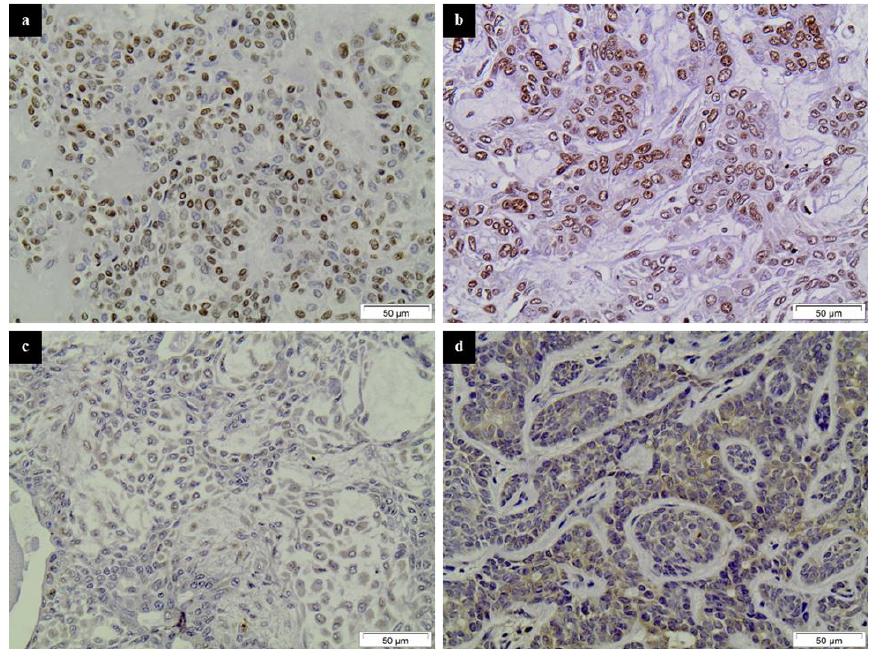
Figure 1. Representative immunostainings of HDAC-1, -2, -4 and -6 in benign SGTs. ( a ) HDAC-1 in a PA, ( b ) HDAC-2 in a PA, ( c ) HDAC-4 in a PA and ( d ) HDAC-6 in a BAD. Streptavidin-biotin- peroxidase, DAB chromogen, Harris hematoxylin counterstain.